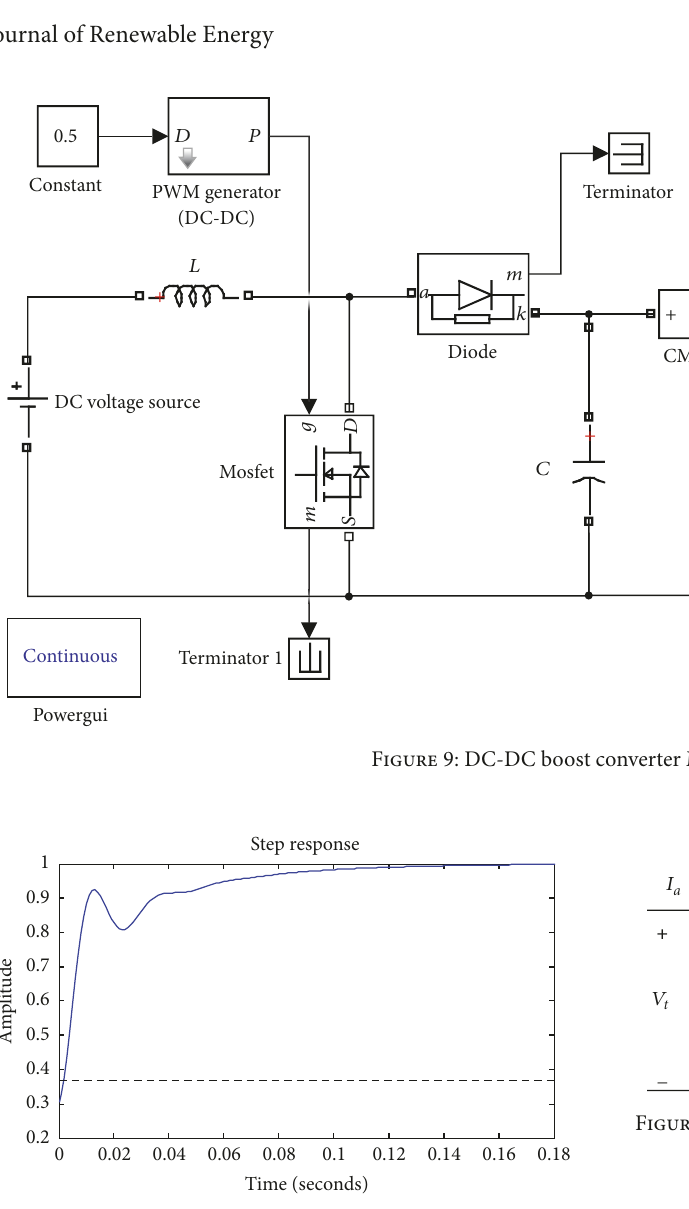
Figure 10: Step response of the system.